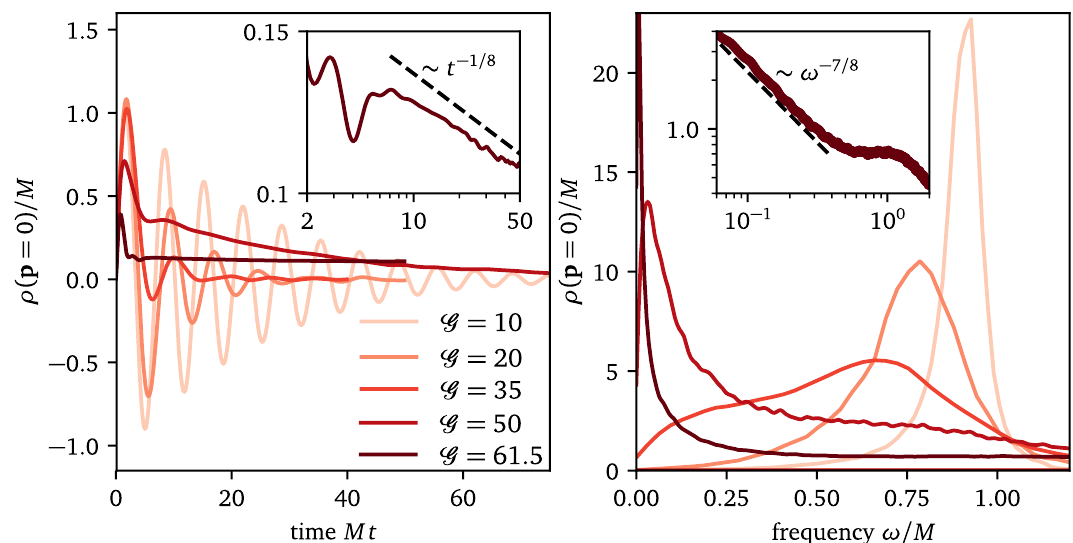
Figure 1: Spectral function in real time (left) and frequency (right). For small G , the real time spectral function exhibits weakly damped oscillations, corresponding to a sharp quasiparticle peak with mass gap approximately given by the one-loop renormalized mass M . As G is increased, higher loop corrections become important, leading to stronger damping and a shift of the maximum away from M . At G = 50, the spectral function already exhibits critical behaviour, showing an exponential decay with correlation length ξ 30 M . Close to the phase transition, G = 61.5, critical t ≈ algebraic decay becomes apparent both in time and frequency space as ξ is larger t than the studied timescales (insets). Dashed lines correspond to the expectations from the 2D static Ising universality class and assuming a dynamic critical exponent z = 2. In this plot, N = 128, a = 0.2 except for G = 61.4, where N = 256. Some regimes of this figure have been previously studied in Refs. [ 37,38,41 ]